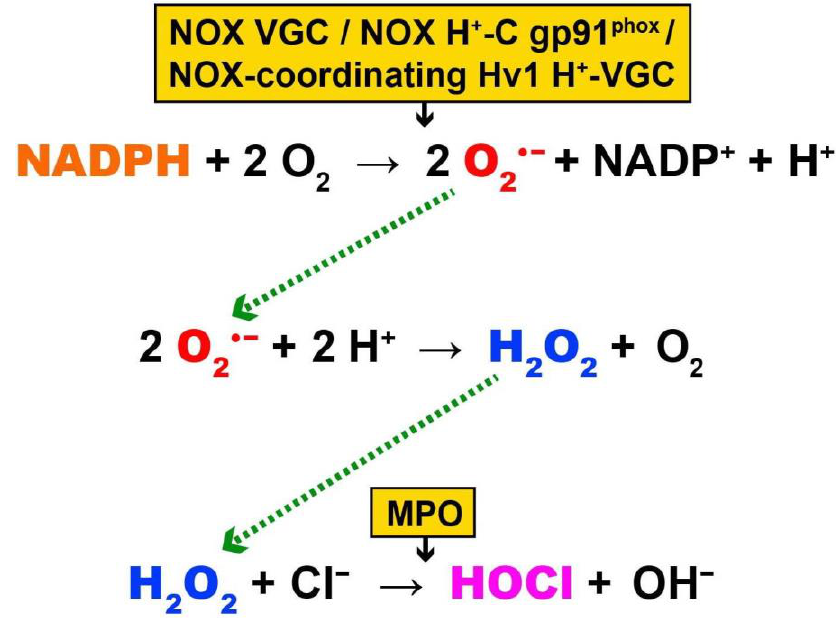
Figure 1. Superoxide radical (O 2 •− ) generated by NOX VGC/NOX H + -C gp91 phox /NOX-coordinating H + -VGC Hv1, which is dismutated to H 2 O 2 , which is then used by myeloperoxidase (MPO) as substrate for the two-electron oxidation of Cl − to cytotoxic ROS hypochlorous acid (HOCl). Table 1. Reactions involved in the biochemistry of ROS.